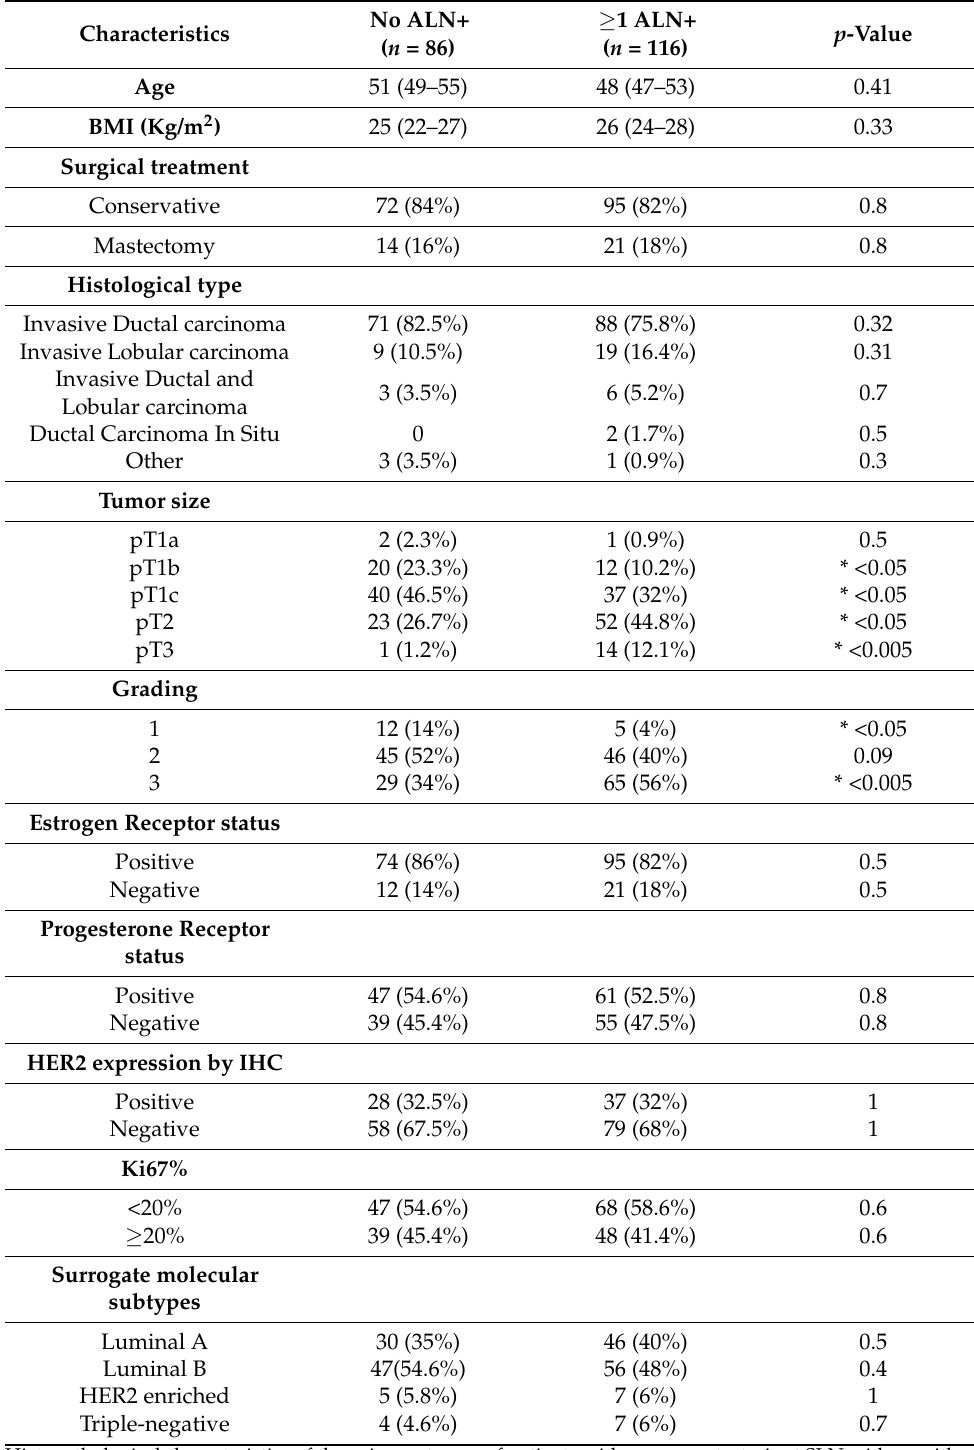
Table 1 summarizes the histopathological characteristics of the primary tumors of the two groups. Table 1. Pathological characteristics of primary tumors of the 2 groups.